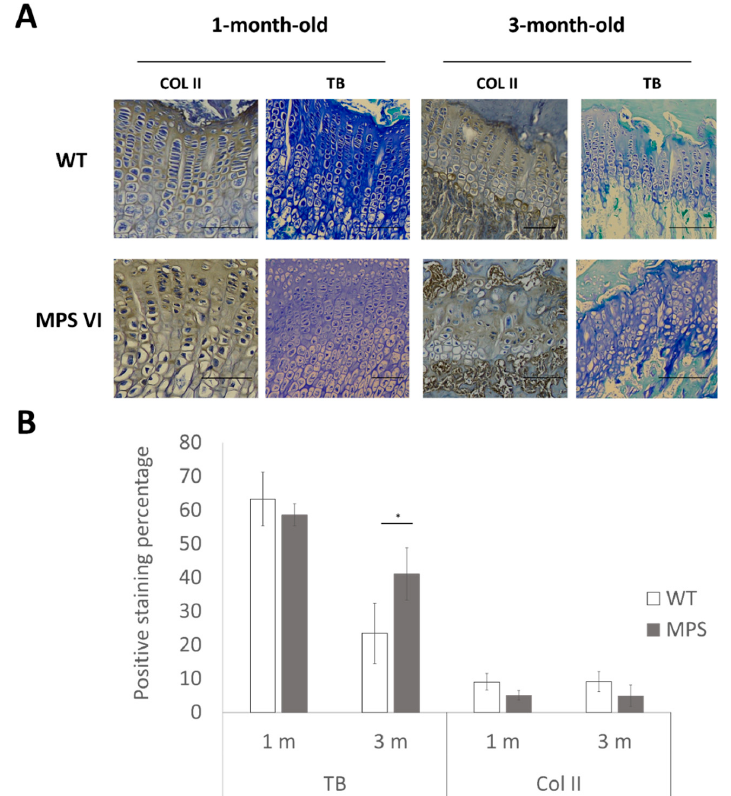
Figure 8. Histology-based analysis of extracellular matrix composition in wild type and MPS VI rats. ( A ) On the left side of both panels, immunohistochemistry for collagen type II (Col II) is shown. On the right side, images of toluidine blue stained (TB) samples are shown. Scale bars correspond to 100 µm. Representative samples ( n = 3 per group); ( B ) Quantification analysis performed using Image J software (mean ± standard deviation; n = 3 per group). Significant differences are noted with an asterisk for p < 0.01.